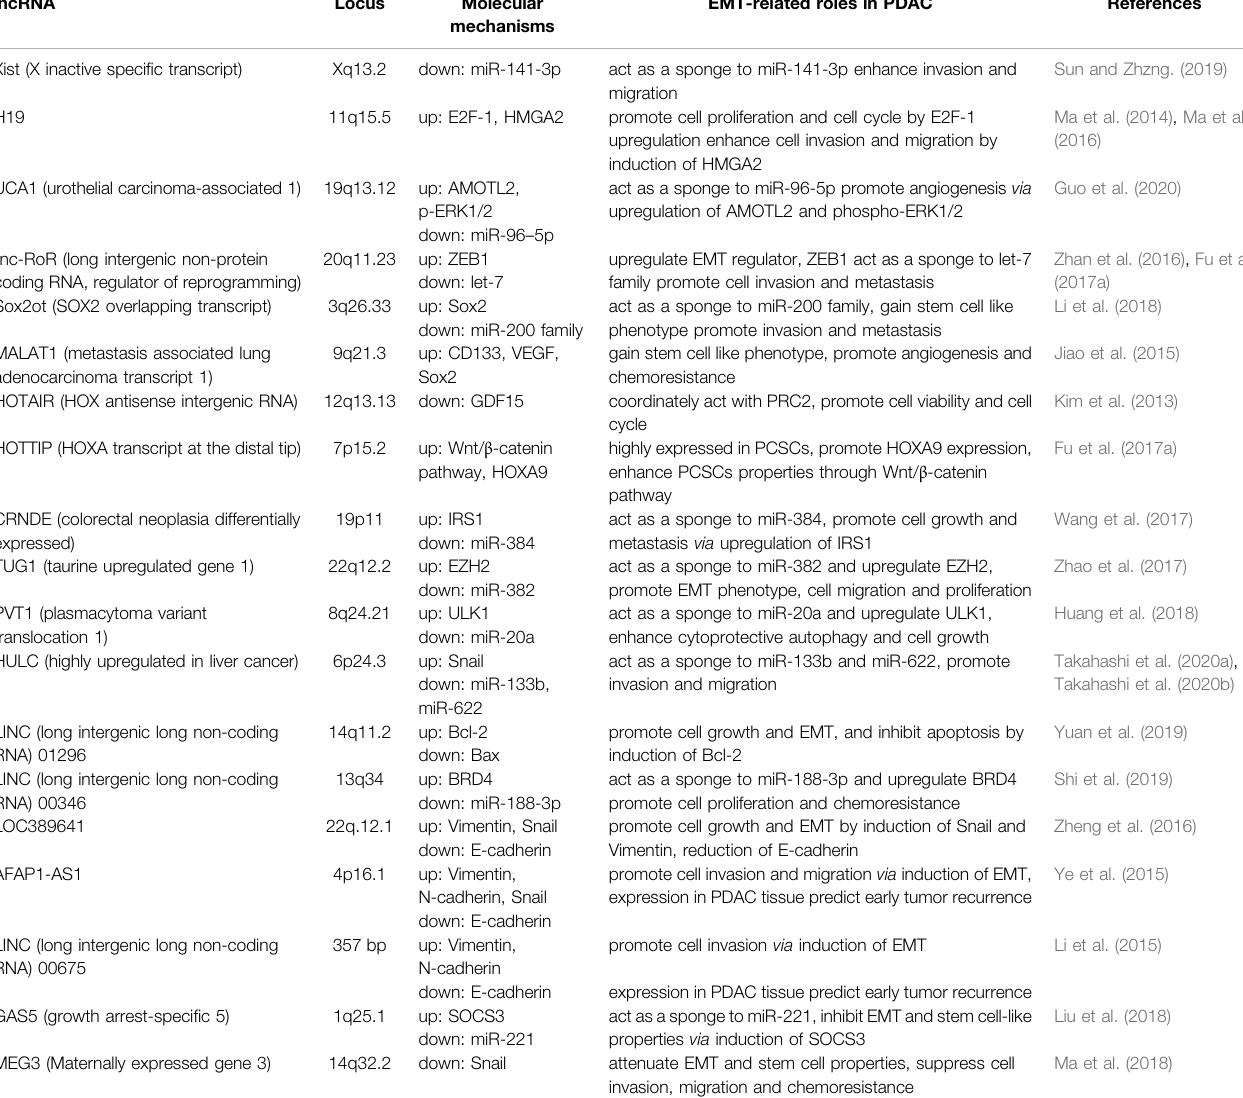
TABLE 1 | LncRNAs in PDAC development through EMT